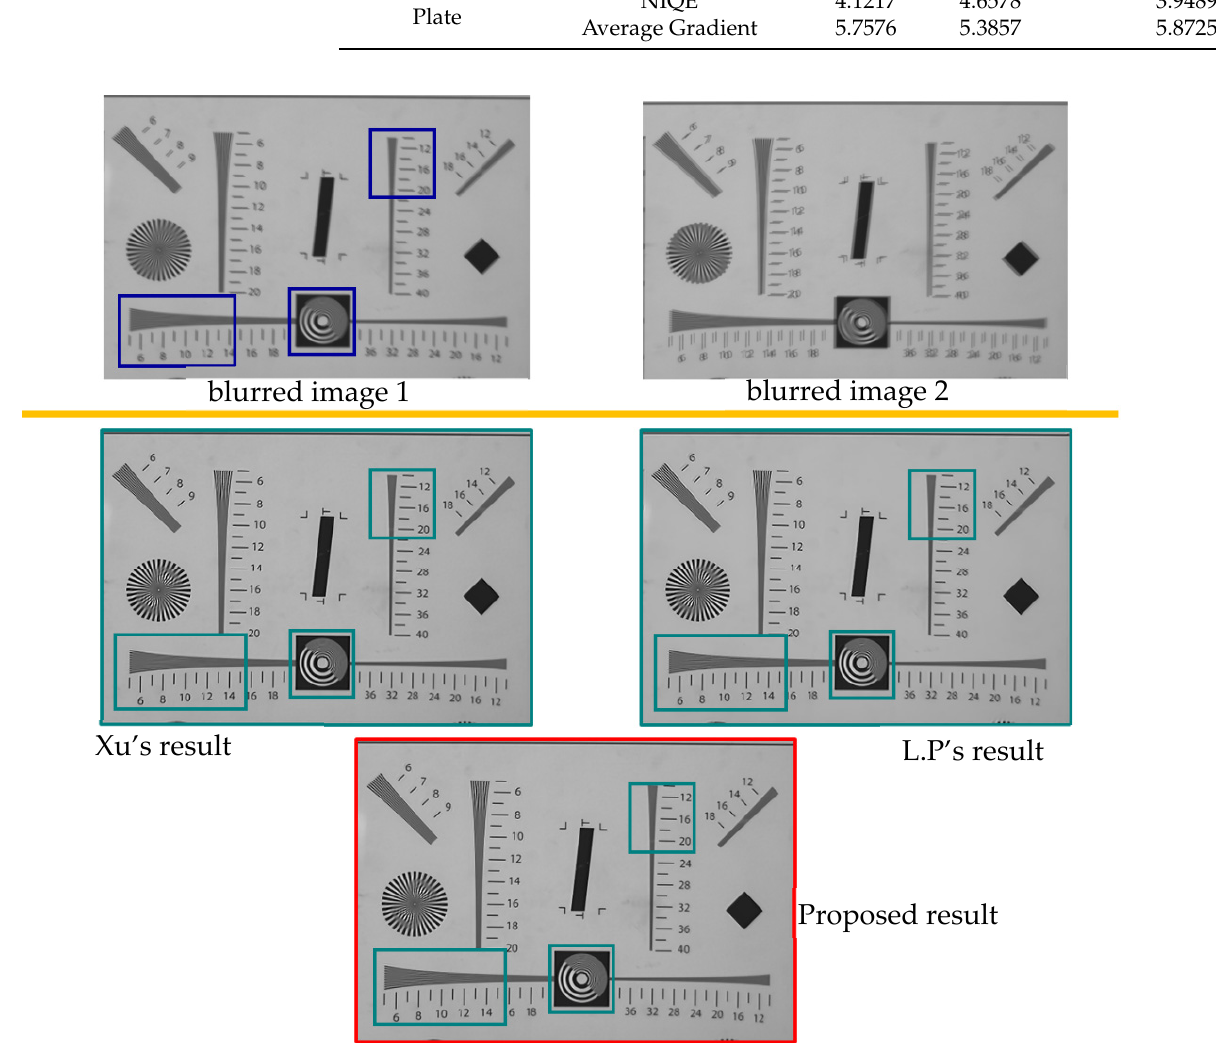
Figure 10. The input blurred images and the restoration. The top line is the blurred images 1 and 2; The middle line is the results of Xu’s and L.P’s methods as space-invariant. The bottom line is the deblurred image using the proposed method as space-variant.